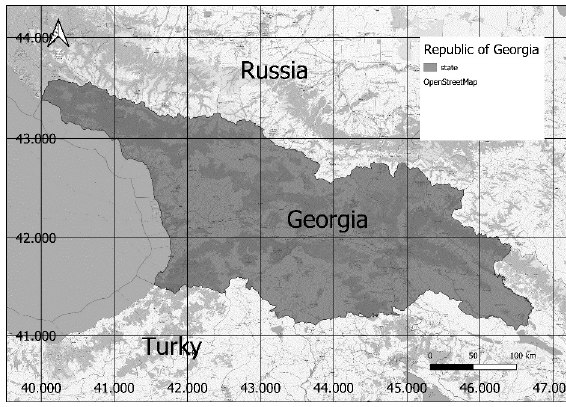
Figure 1. Republic of